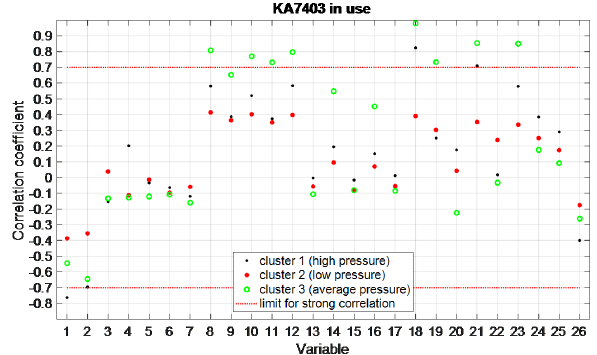
Figure 6: Correlation coeflcients for three clusters of booster